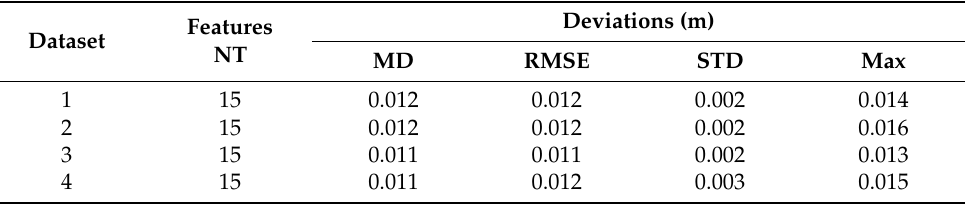
Table 2. Adjustment accuracy. The ‘Dataset’ column represents the dataset index. The ‘Features’ column gives the number NT of the detected points in each dataset. The deviation is calculated as the spatial distance between the corresponding features in the overall data.